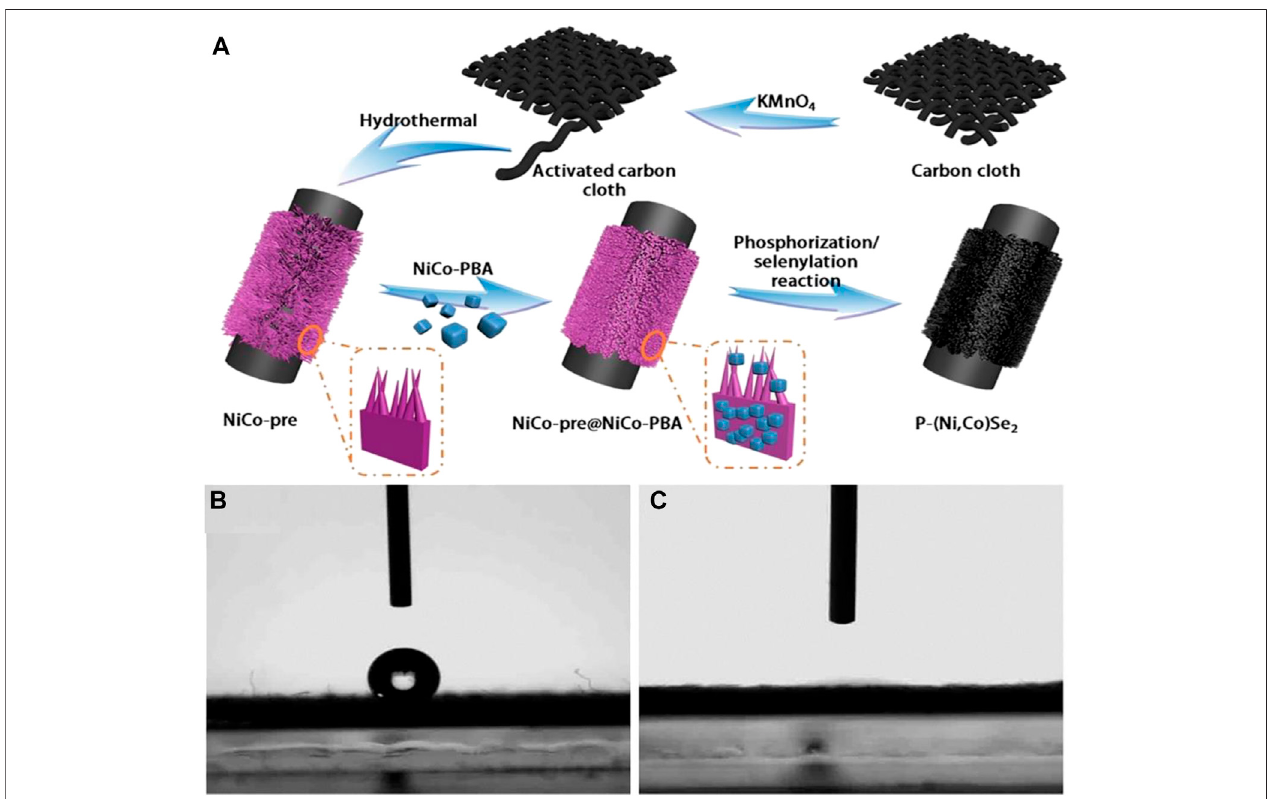
FIGURE 22 | Schematic illustration of the fabrication procedure of P-(Ni,Co)Se 2 NAs on activated carbon cloth.